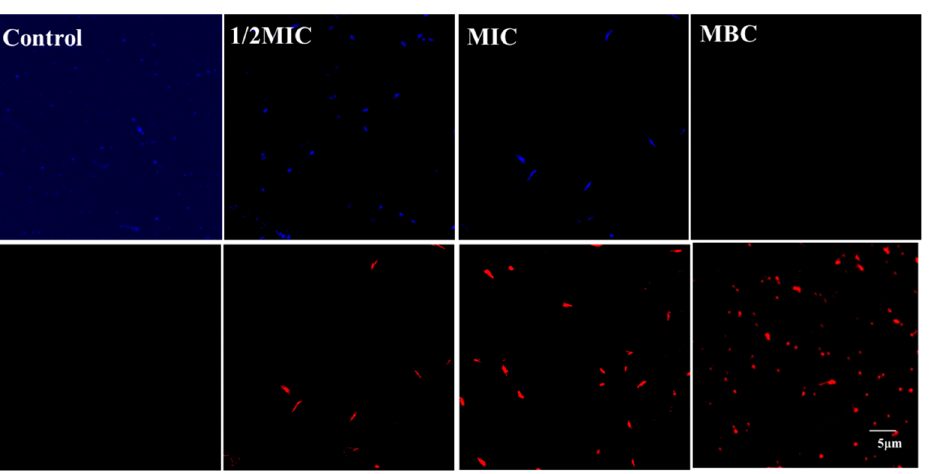
Figure 3. Effect of juglone on cell viability. CLSM (confocal laser scanning microscopy) was used to analyze the viability of P. aeruginosa exposed to different concentrations of juglone.